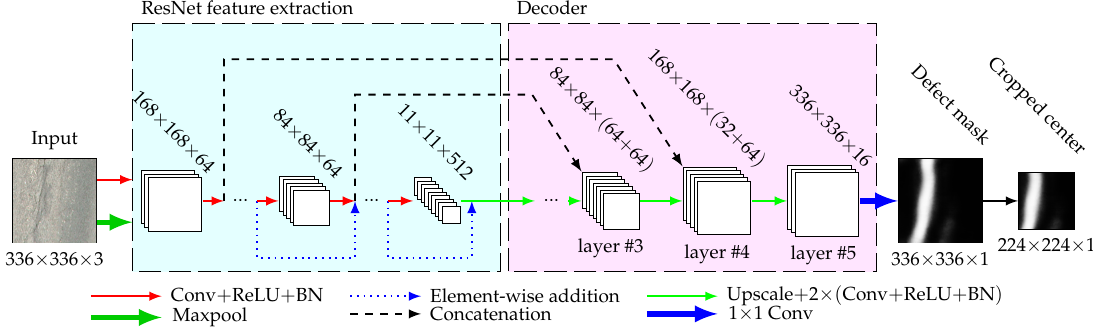
Figure 8. Architecture of the defect segmentation U-Net used in this